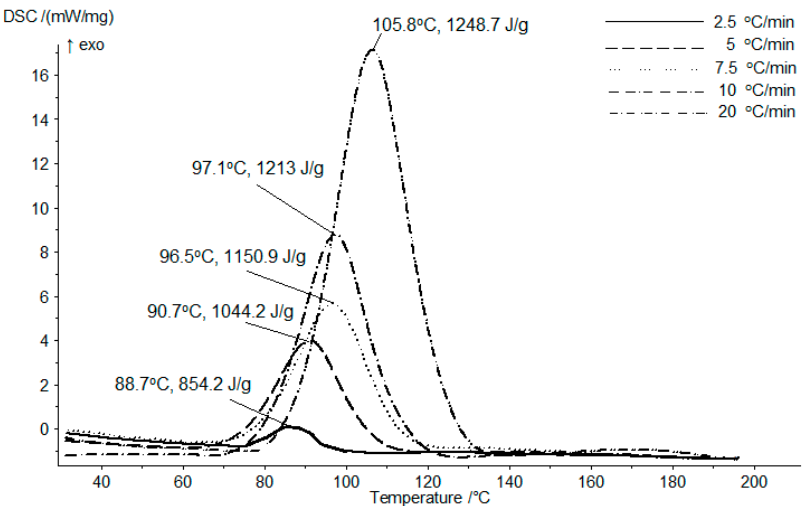
Figure 1. The differential scanning calorimetry (DSC) diagram for the copolymerization process Figure 1. The di ff erential scanning calorimetry (DSC) diagram for the copolymerization process between the D-mannose oligomer and HPA, weight ratio 1:2. between the D-mannose oligomer and HPA, weight ratio 1:2.